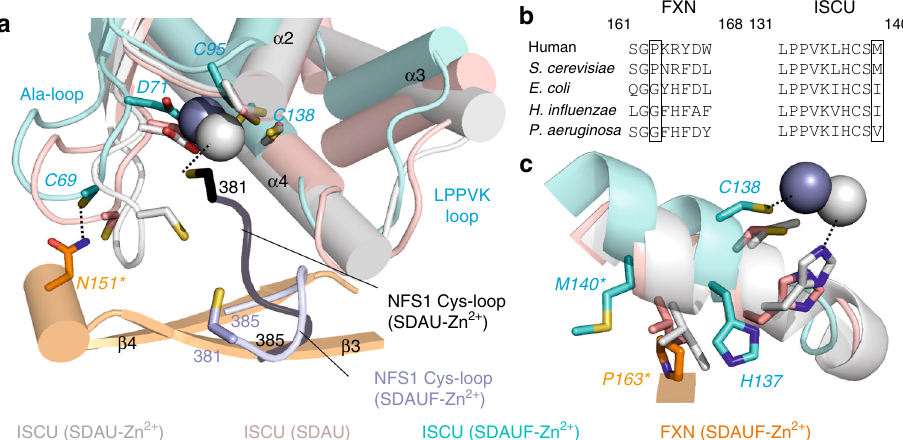
Fig. 3 Comparing structures with and without FXN. a . Same view of SDAUF-Zn 2 + as Fig. 2c, superimposed with ISCU subunits from SDAU-Zn 2 + (5WLW) and SDAU (5WKP) structures. NFS1 Cys-loops from SDAUF-Zn 2 + and SDAU-Zn 2 + are shown. b . Sequence alignment of FXN region containing Pro163 (human numbering) and the ISCU L 131 PPVKLHCSM 140 loop. Sequences shown include FXN and ISCU orthologues from human (Uniprot ID Q16595 and Q9H1K1, respectively), S. cerevisiae (Q07540, Q03020), E. coli (P27838, P0ACD4), H. in fl uenzae (P71358, Q57074) and P. aeruginosa (Q9HTS5, Q9HXI9) c . ISCU L 131 PPVKLHCSM 140 loop from the superimposed structures, adjacent to FXN Pro163 (orange). Human ISCU encodes Met at residue 140 (cyan stick), while in SDAU-Zn 2 + and SDAU structures Met was substituted to Ile (white and pink sticks respectively). In both panels a and c, FXN mutagenesis residues and ISCU Met140 are asterisked, and Zn 2 + ions are shown as spheres. Dashed lines denote potential hydrogen bonds or Zn 2 +